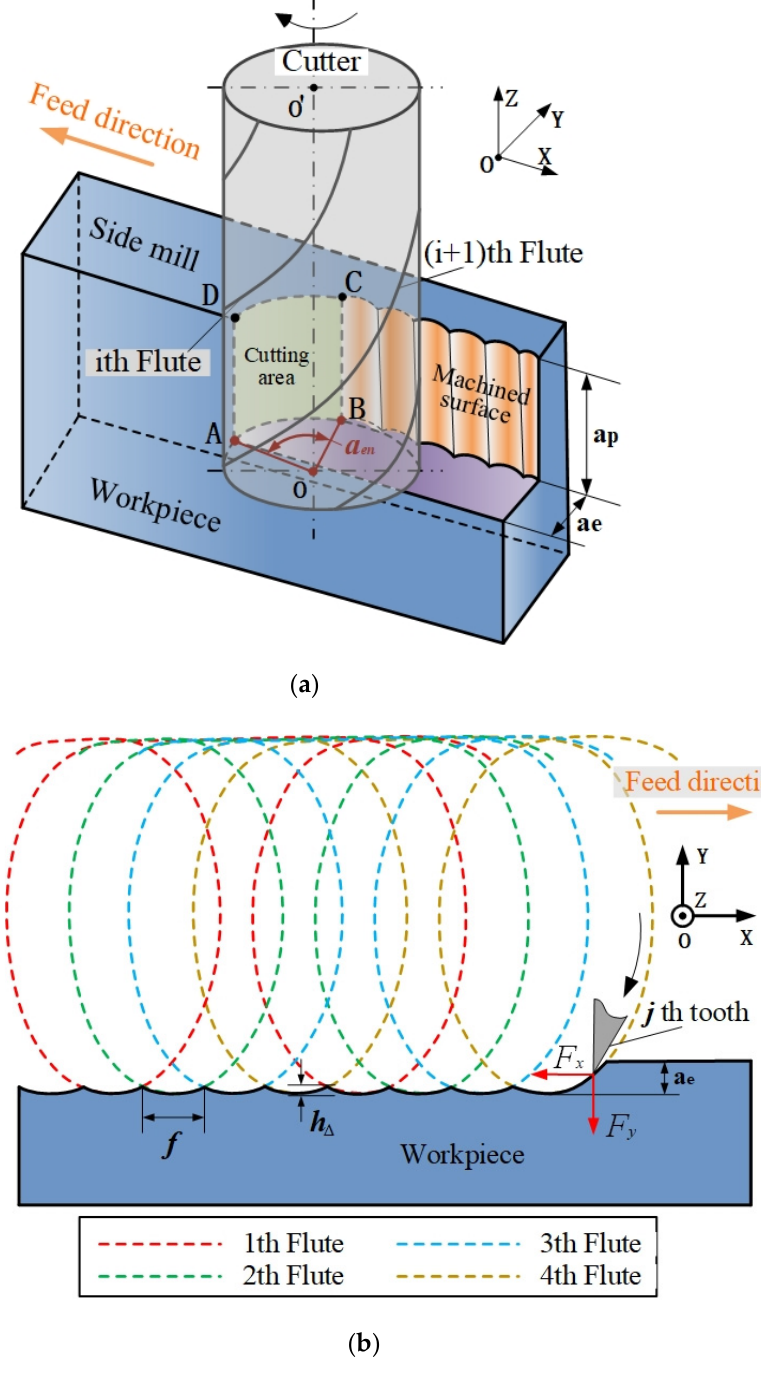
Figure 6. The formation of the peripheral milling surface. ( a ) The formation of the side milling surface. ( b ) 2D trajectory of the tool tooth.